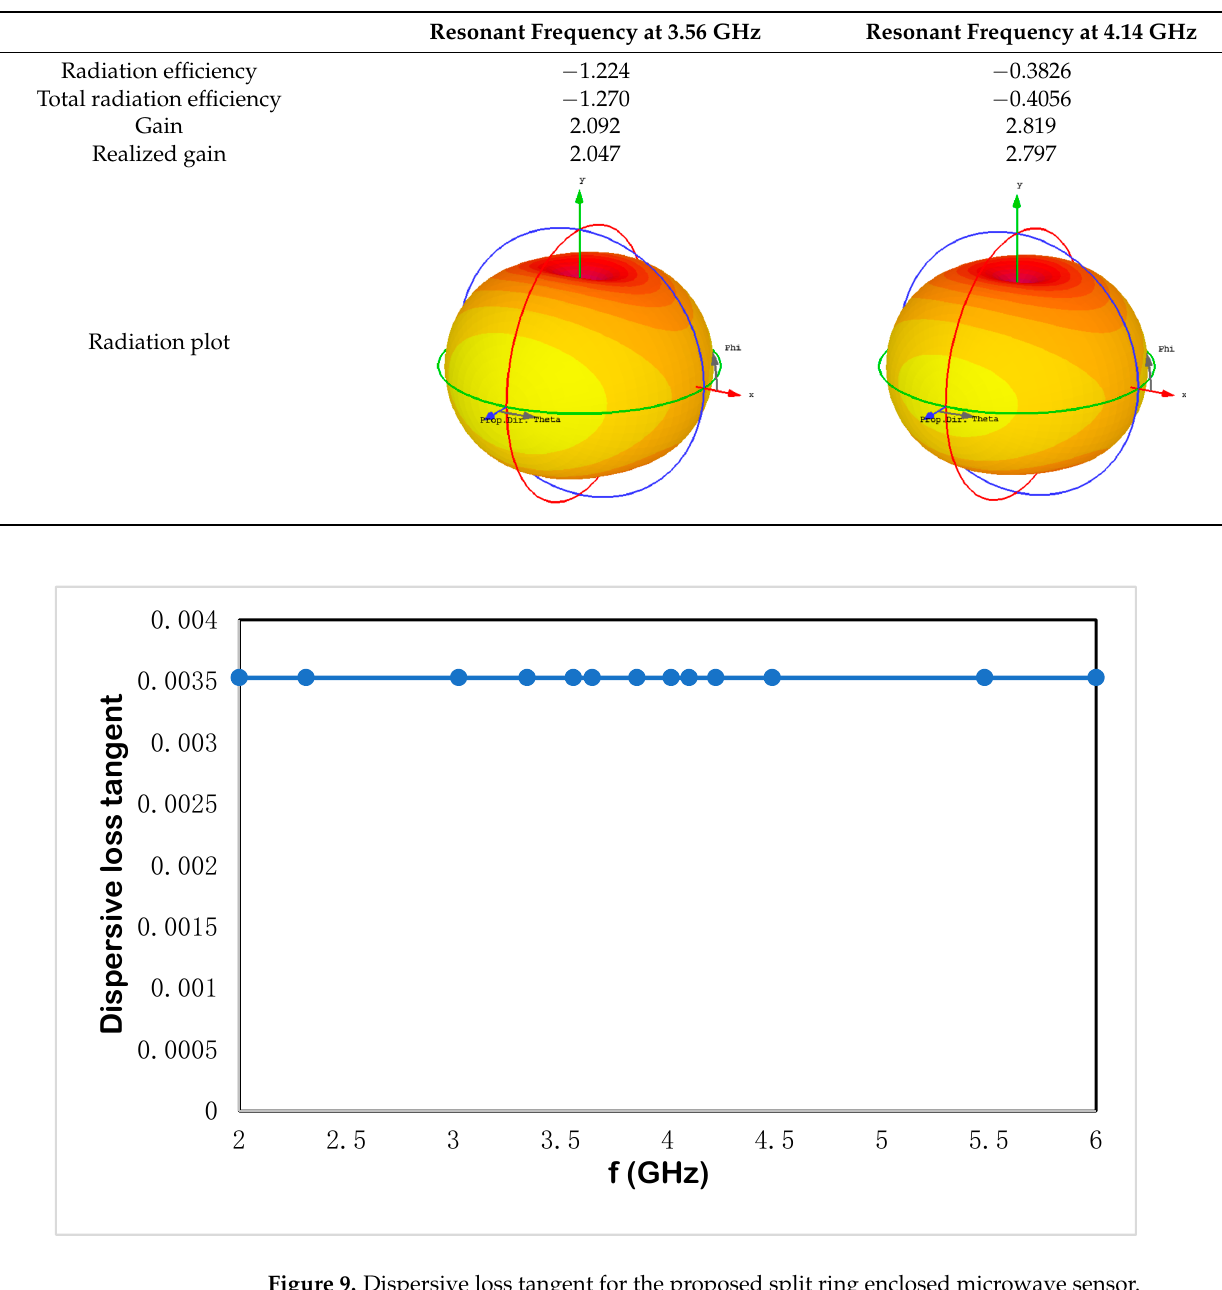
coaxial cable, and the corresponding results show discrepancies due to the fringing field